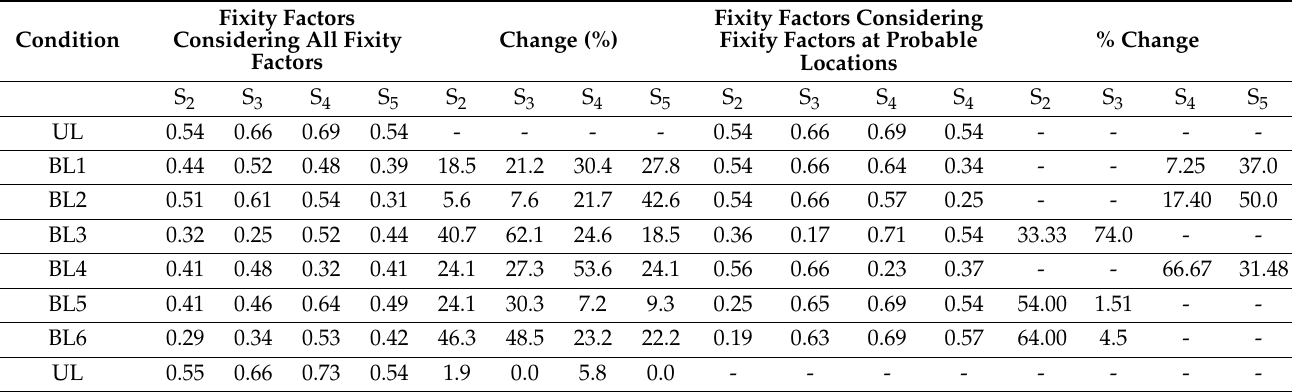
Table 6. Estimated fixity factors for different